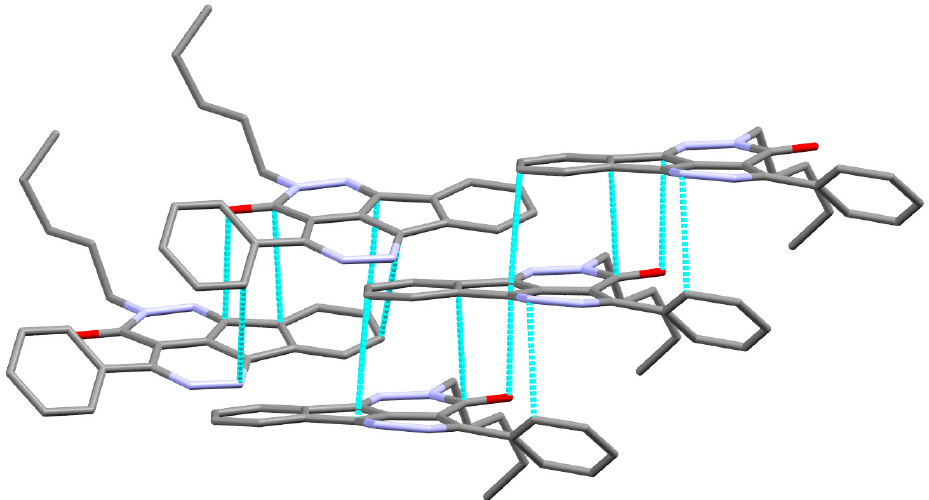
Figure 4. π – π stacking (lower) in